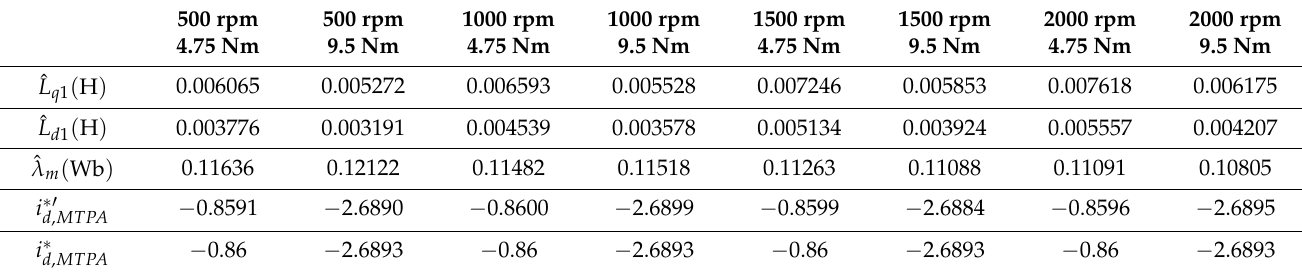
using modified L d 0 with i ∗ d , MTPA